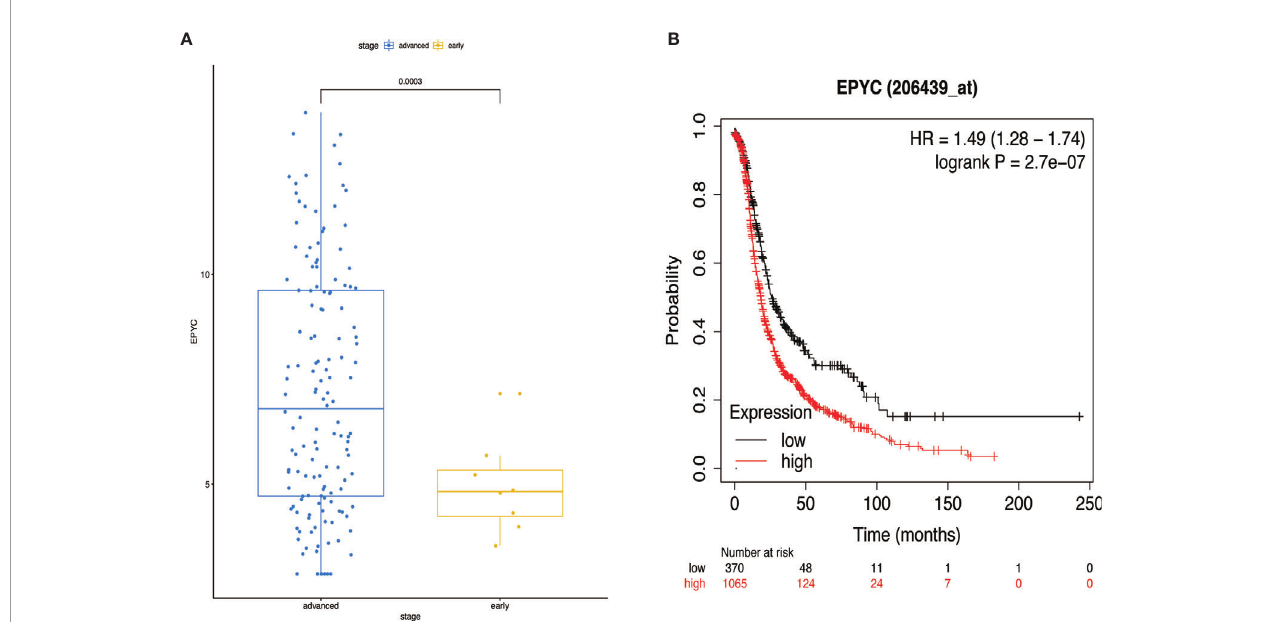
FIGURE 6 | The clinical signi fi cance of EPYC. (A) When the EPYC expression level of advanced ovarian cancer was compared with that of early ovarian cancer, the expression level of advanced ovarian cancer was also signi fi cantly higher than that of early ovarian cancer. (B) The high expression of EPYC in serous ovarian cancer was associated with poor prognosis, analyzing by Kaplan-Meier Plotter website.